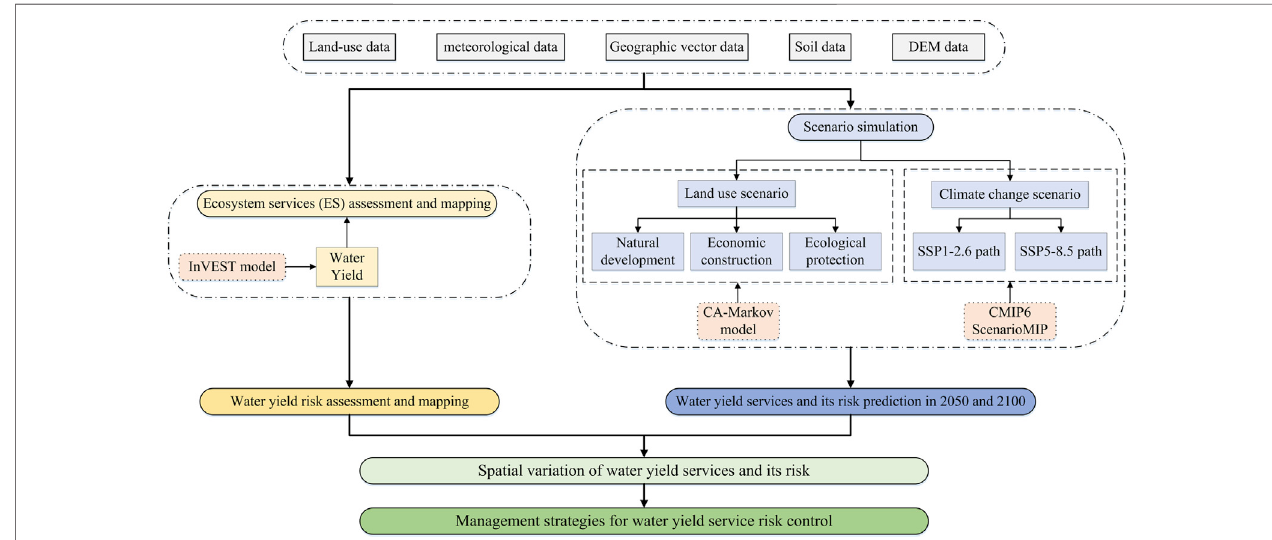
FIGURE 1 | Research fl